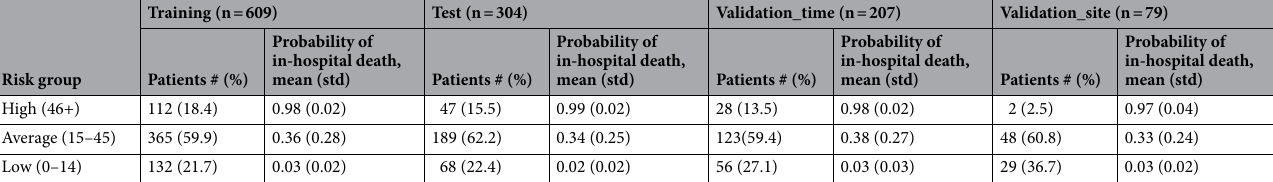
Table 3. Patient risk stratification based on risk